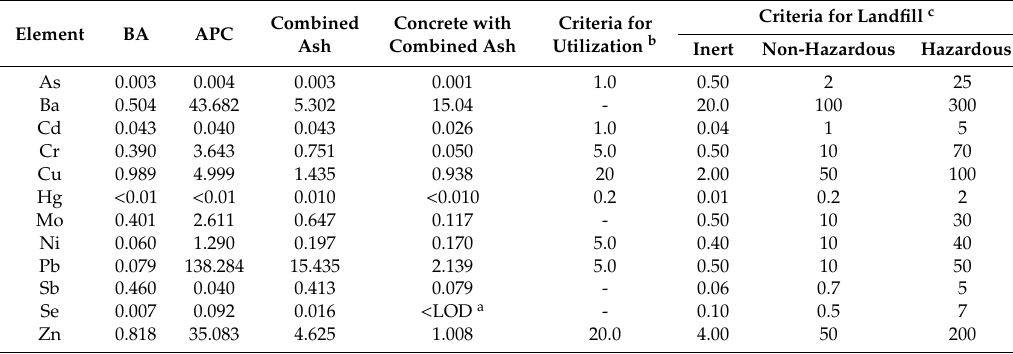
Table 8. Leaching results for MSWI BA, APC residue, and the formulated concrete mixture (mg / kg) [182]. Element BA APC